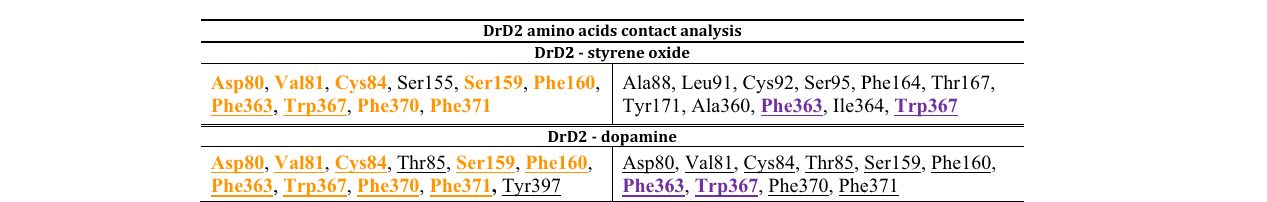
Table 1: List of the receptor amino acids belonging to the interaction sphere of styrene oxide ( top panel ) and dopamine ( bottom panel ) at the beginning ( left column ) and at the end ( right column ) of the MD simulation. The amino acids in orange are the ones belonging to both the ligands interaction spheres at the beginning of the MD simulations. The amino acids in purple are the ones belonging to both the ligands interaction spheres at the end of the MD simulations. The amino acids that are underlined are the ones remaining in the ligands interaction spheres during the whole simulation. The receptor amino acids belonging to the ligand interaction sphere are those having atoms at a distance shorter than 3.5 Å from any of the ligand